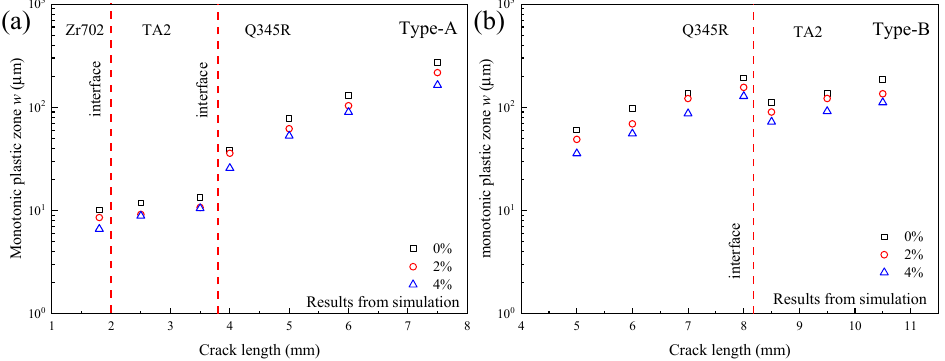
Figure 4. Effect of pre-strain on w for the crack normal to the interface: ( a ) Type-A crack, ( b ) Type-B